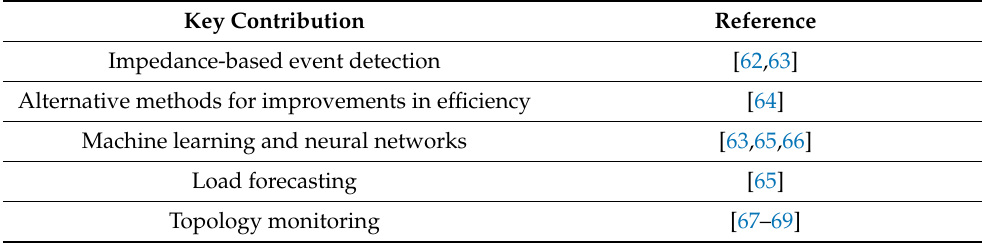
Table 3. Summary of contributions. Key